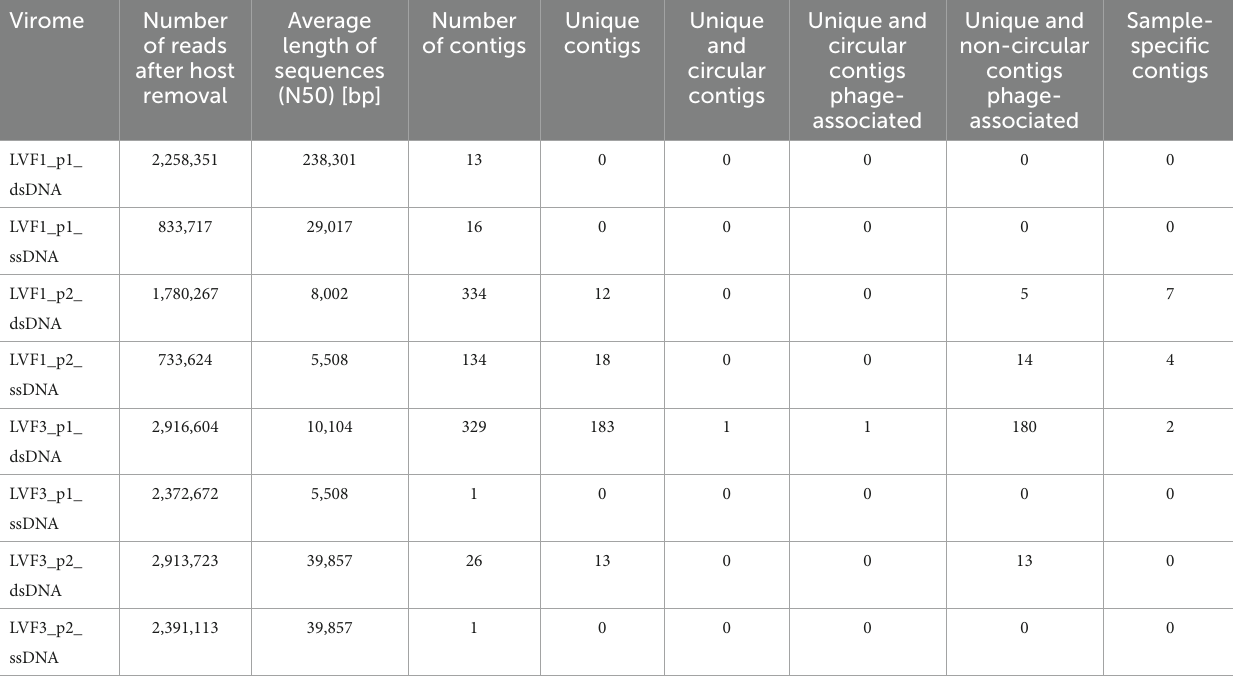
TABLE 3 dsDNA and ssDNA viromes associated with Brevundimonas pondensis and Serratia marcescens . Virome Number of reads after host